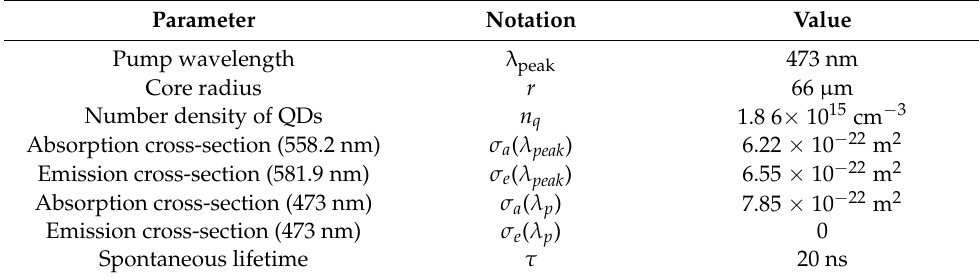
Table 1. Parameter values used in the simulation.